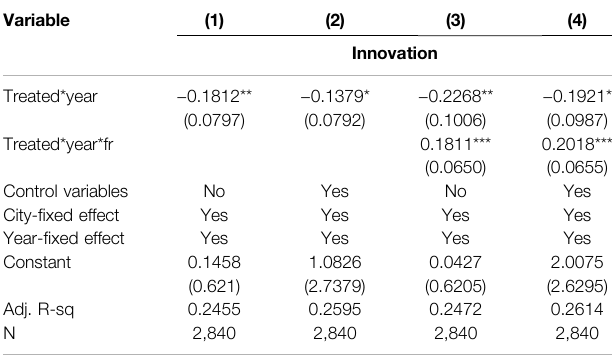
TABLE 11 | Test for the mechanism: innovation effect.